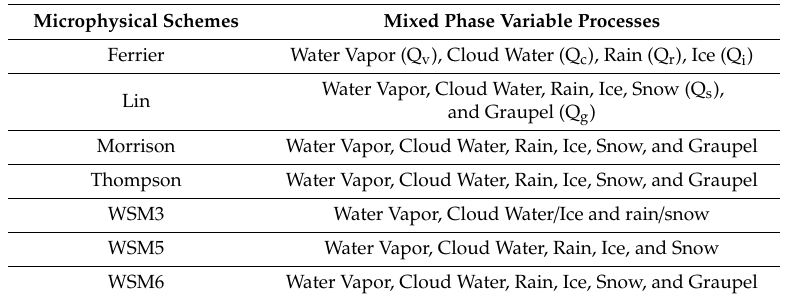
Table 2. The mixing ratios of the prognostic variables in the Microphysical Schemes.